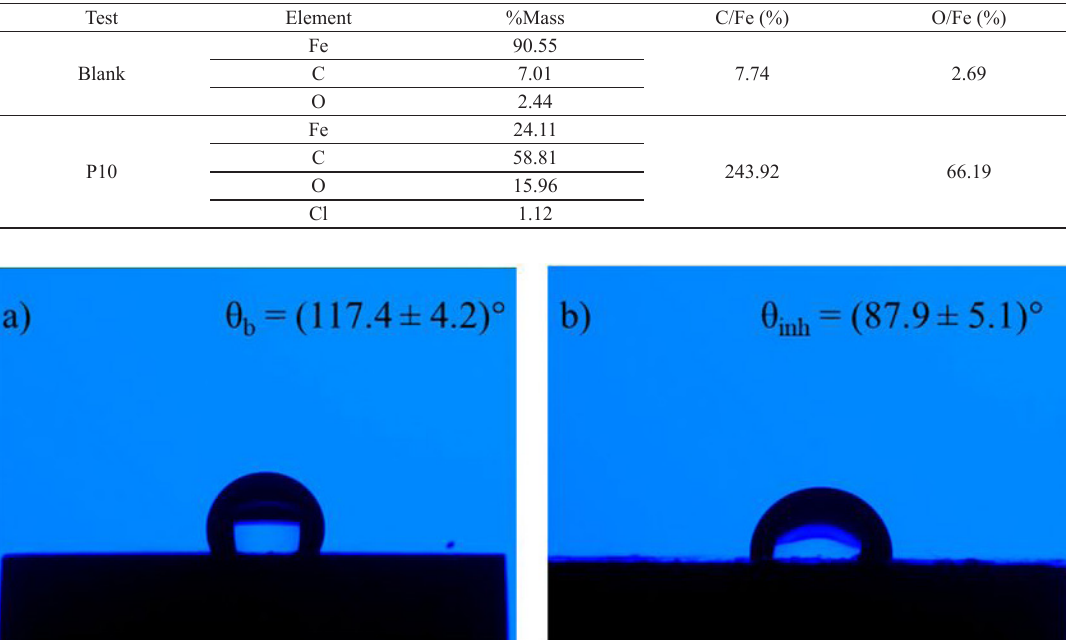
Table 6. Element percentages according to SEM-EDX analysis of API P110 carbon steel in the absence and presence of P10 (3.5% v/v) at 333 K. Test Element